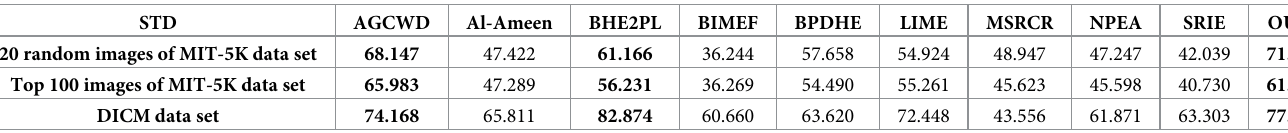
Table 16. Average image standard deviation values of three groups of